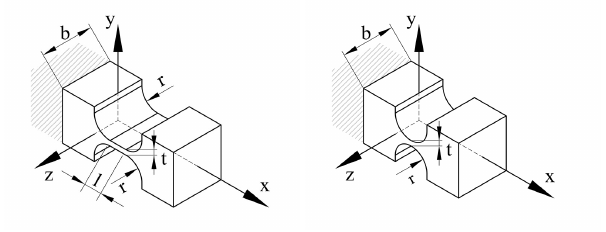
Figure 10. Corner-filleted and right-circular SaNFHs.